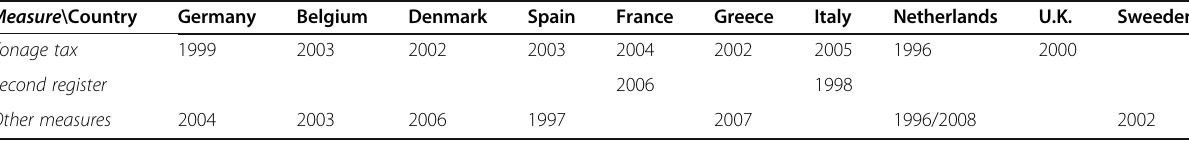
Table 2 Timing of the adoption of maritime transport policies by EU Member States Measure